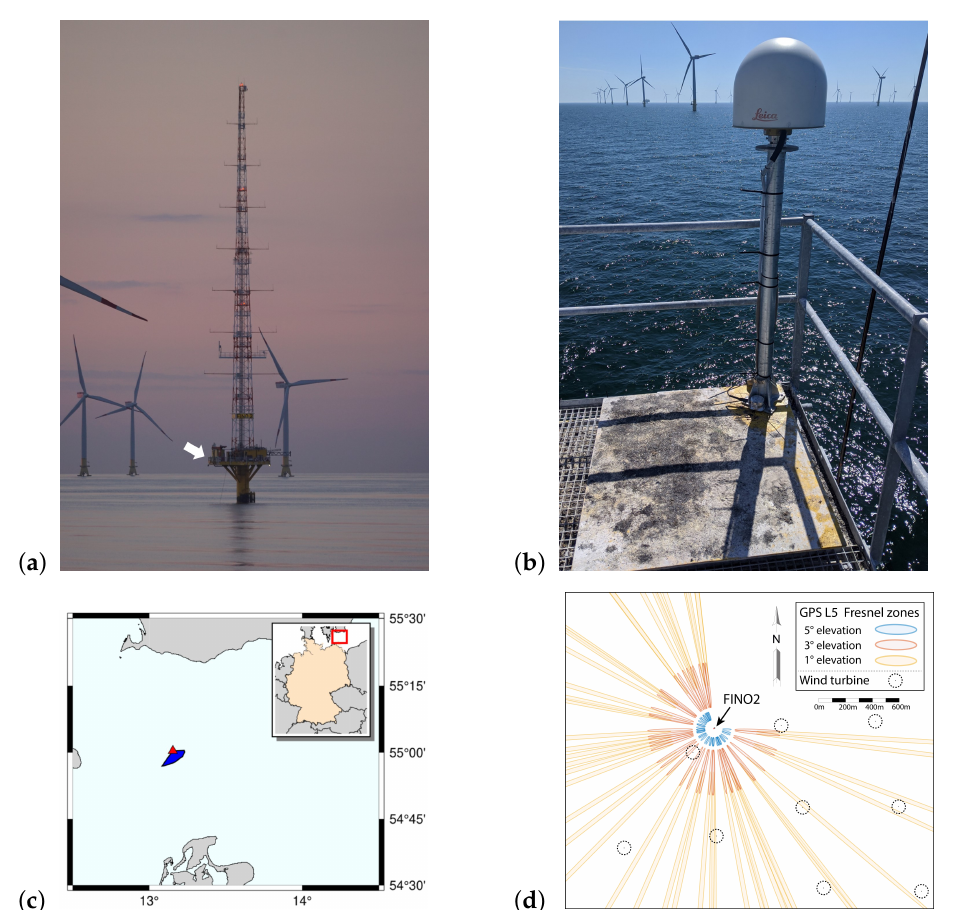
Figure 8. ( a ) Research station FINO2 in the Baltic Sea. The GNSS antenna is mounted on the platform marked with the white arrow. ( b ) The GNSS antenna. ( c ) Map with location of FINO2. The position of FINO2 is highlighted with the red triangle, and the area where wind turbines are located is displayed in blue. ( d ) Detailed map with location of individual wind turbines and reflection zones for different satellite elevation angles. (Photos: Federal Agency for Cartography and Geodesy,